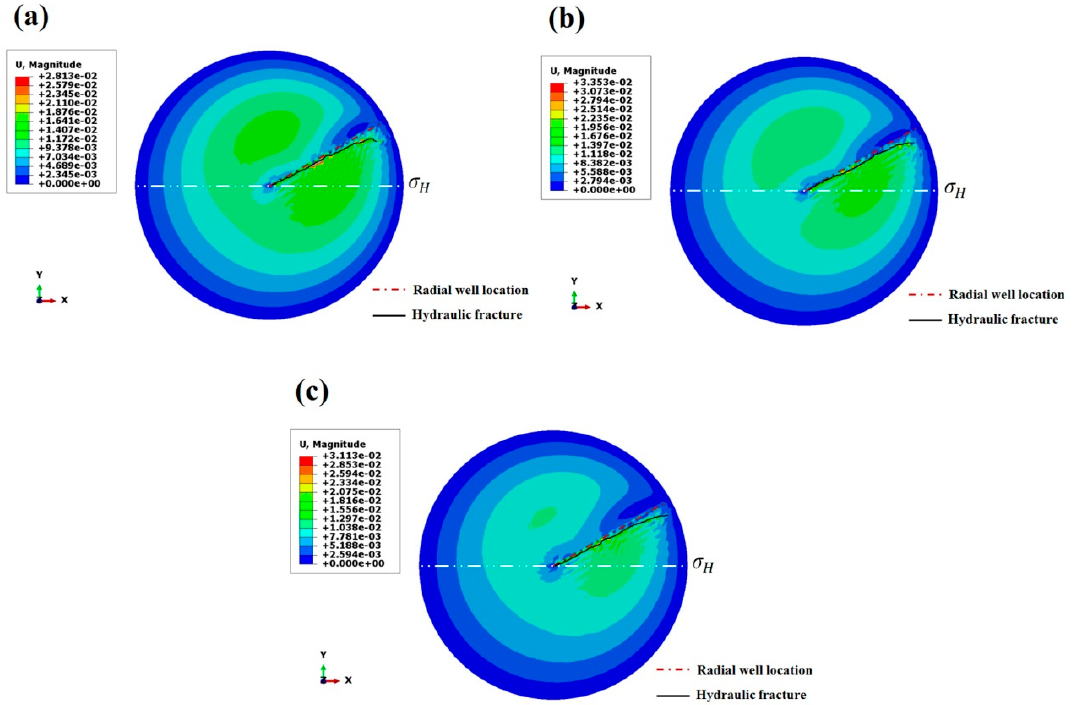
Figure 11. Simulation results of hydraulic fracture propagation guided by a single radial well under different Poisson ratios of reservoir rock: ( a ) 0.15; ( b ) 0.2; and ( c ) 0.25.